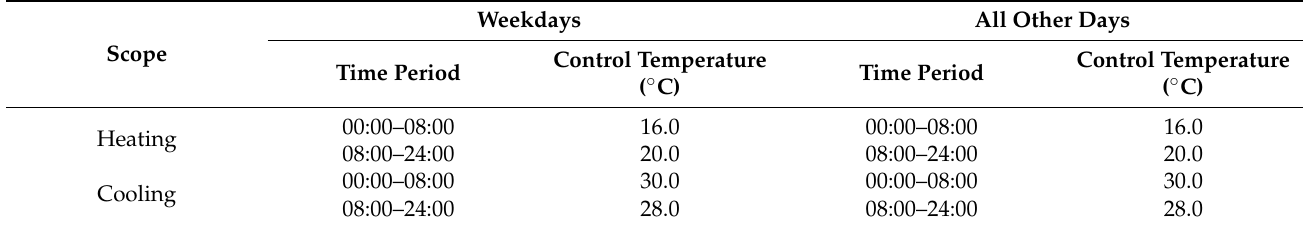
Table 4. Indoor environment control temperatures.